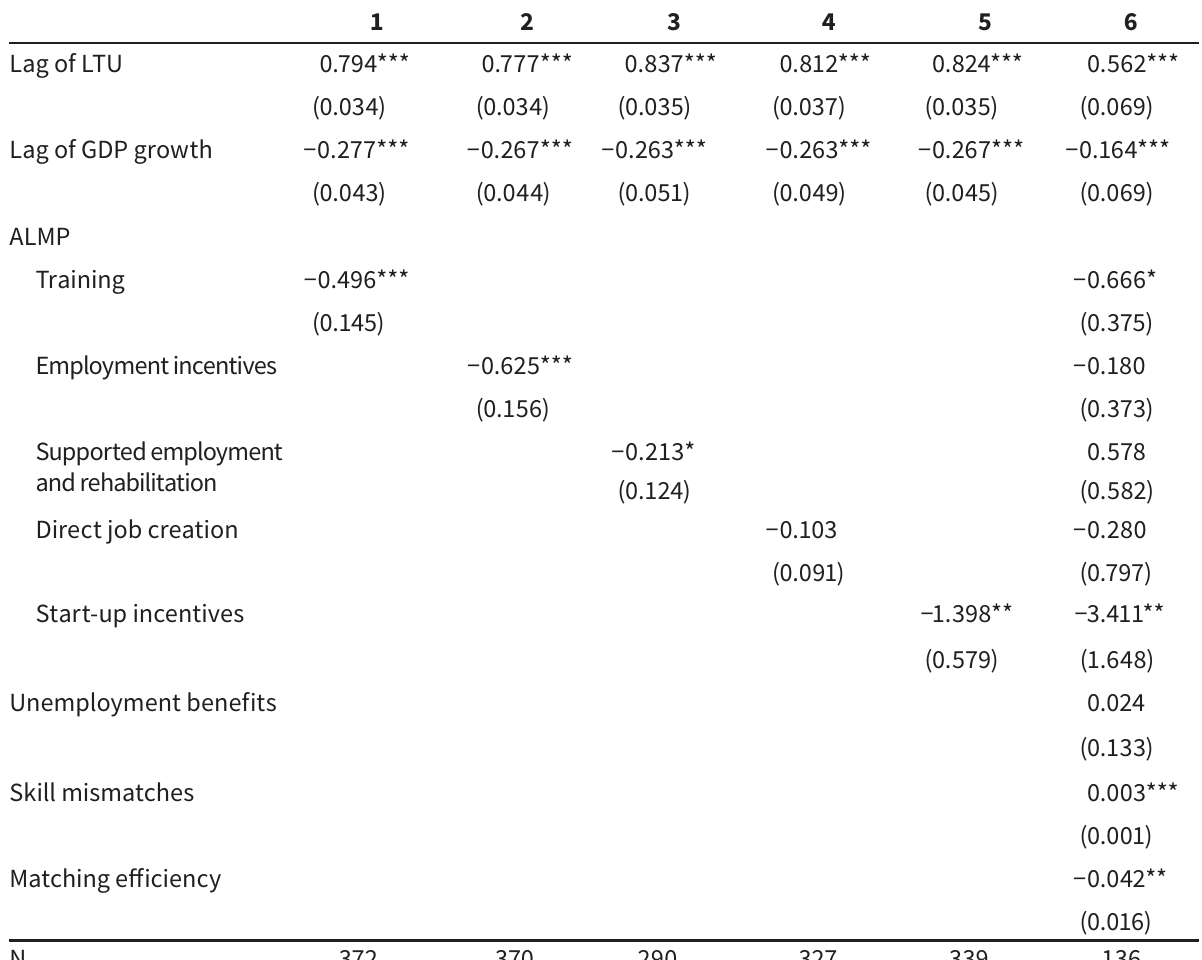
Multivariate regressions with individual ALMPs Dependent Variable: Incidence of